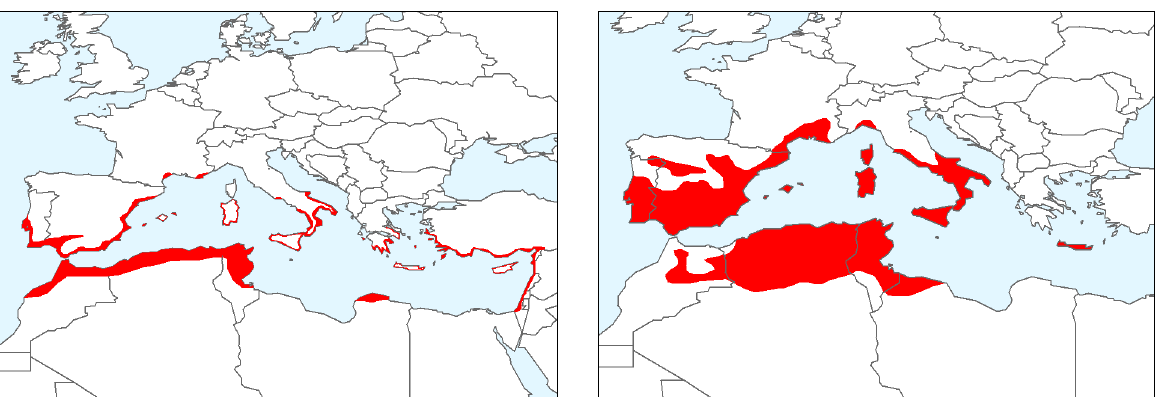
Fig. 8. Mediterranean ranges for Olea europea (left) and Rosmarinus officinalis